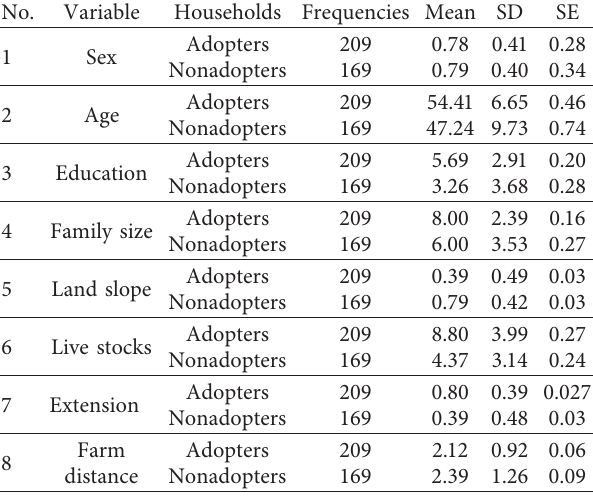
Table 1: Descriptive result of adopting households and their